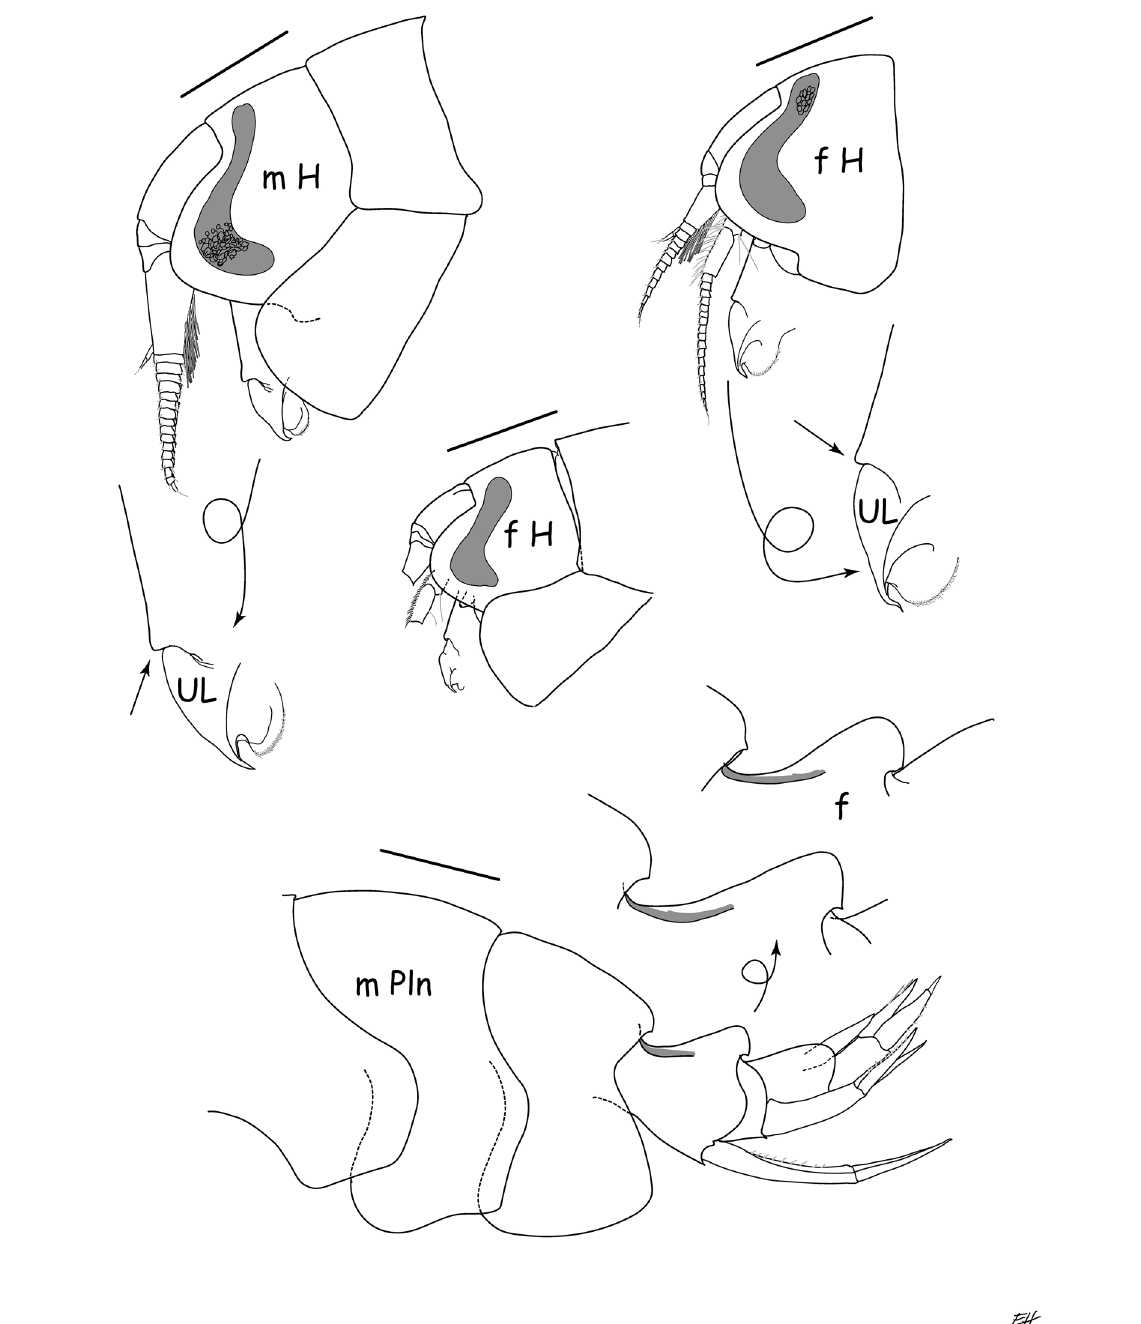
Fig. 19. Abyssorchomene scotianensis (Andres, 1983), ♀, 12 mm (CMNC 2022-0005); ♀, 9.5 mm (CMNC 2022-0006); ♂, 12.4 mm (CMNC 2022-0007), RV Polarstern ANT XXIII-8 (IPY-CAML), station PS69-706-7, Weddell Sea, off East Peninsula, Larsen B, depth 828 m, 15 January 2007. Female head shown in middle of figure is the 9.5 mm specimen. Scale bars = 1